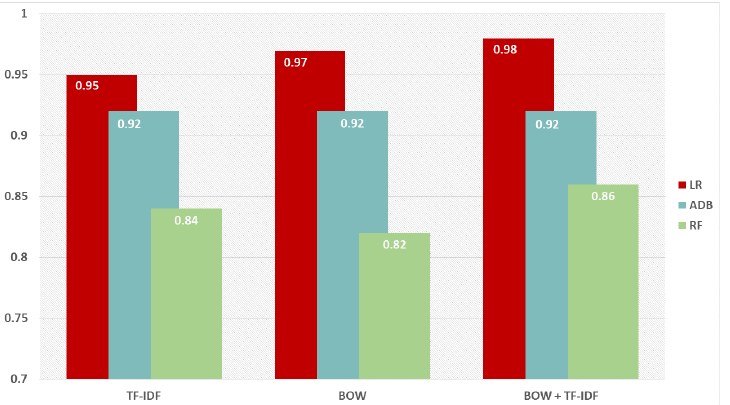
Figure 4. Performance comparison of ML models using three different feature extraction